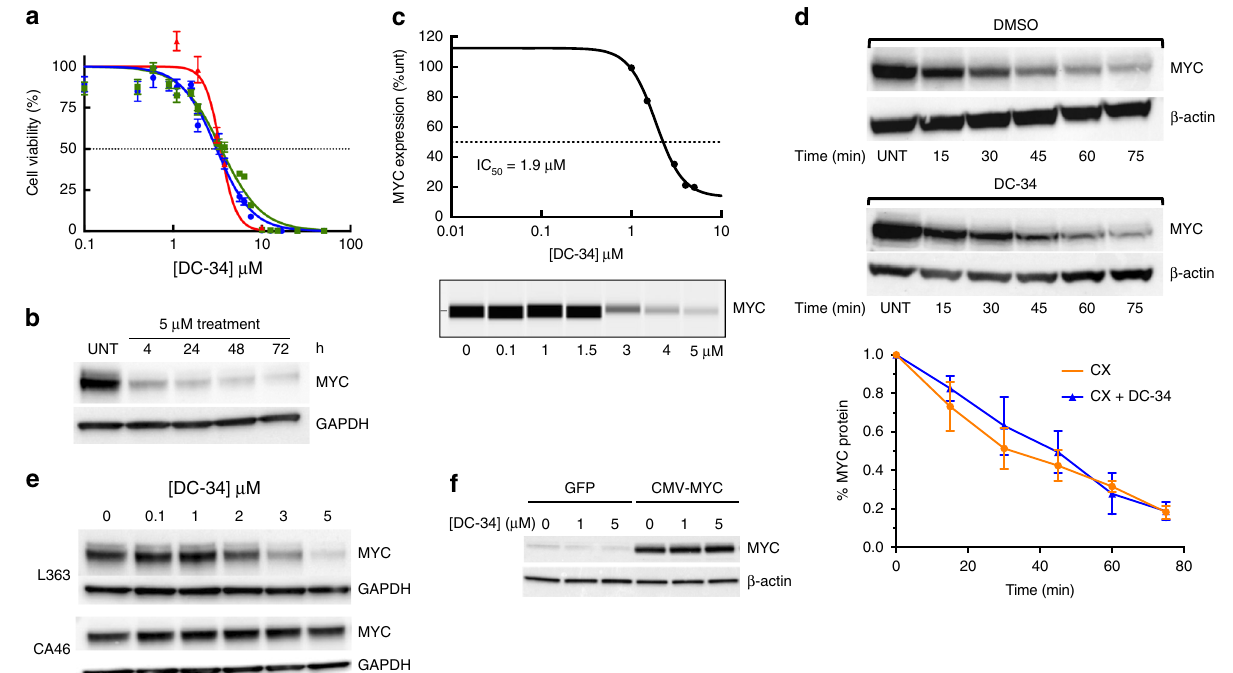
Fig. 3 DC-34 silencs MYC expression in cancer cells. a Inhibition of L363 MM cell proliferation at 24 (IC 50 = 3.4 µ M) (red), 48 (IC 50 = 3.4 µ M) (green) and 72 h (IC 50 = 3.1 µ M) (blue). b Inhibition of MYC protein translation with 5 μ M of DC-34 is sustained over time in L363 cells. c The half maximal inhibitory concentration (IC 50 ) of DC-34 with respect to MYC protein inhibition as determined by Peggy protein expression. d A Western blot of MYC protein during a representative cycloheximide-chase degradation experiment with L363 multiple myeloma cells. Cells were treated with 10 µ g/mL of cycloheximide (CX) in the absence or presence of DC-34 (5 µ M) and MYC protein expression was assessed at indicated time points. β -actin was used as loading control. e MYC protein levels are inhibited as a function of the dose of DC-34 in L363 cells; only the highest dose of DC-34 affected MYC in the more resistant CA46 Burkitt ’ s lymphoma cells. f Western blot analysis of 293T cells transiently transfected with either GFP or CMV-MYC plasmid (the CMV promoter lacks a MYC G4) (right) and dosed with different concentrations of DC-34. All western blots were exposed for <1